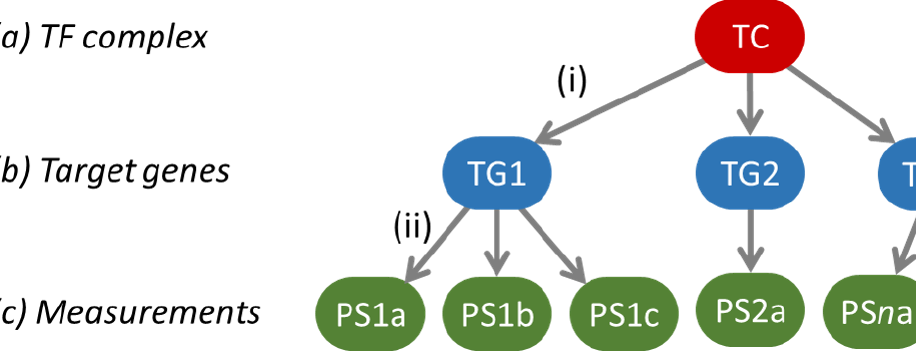
Figure 1. The general structure of the Bayesian network models used to model a pathway’s transcriptional program. The green ovals indicate the probesets on the Affymetrix arrays used to measure target gene levels, and the respective target genes are indicated in the blue ovals as TG 1 to n. After calibration, the model is used to infer backwards from the target gene levels what the odds are that the pathway-associated transcription factor complex (TC) is active or not, as a quantitative readout for signaling pathway activity.